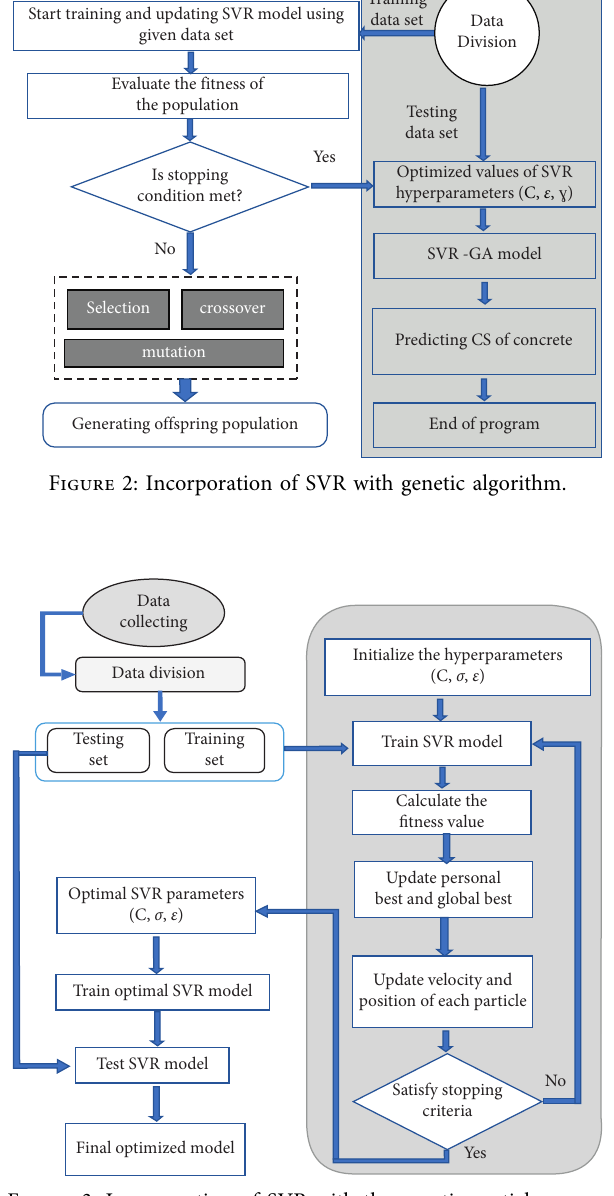
Figure 3: Incorporation of SVR with the genetic particle swarm algorithm.